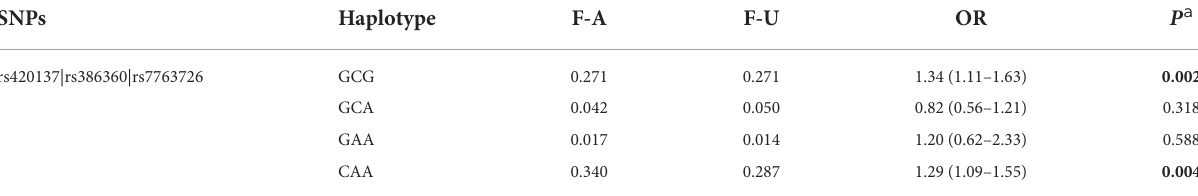
TABLE 7 Haplotype analysis.